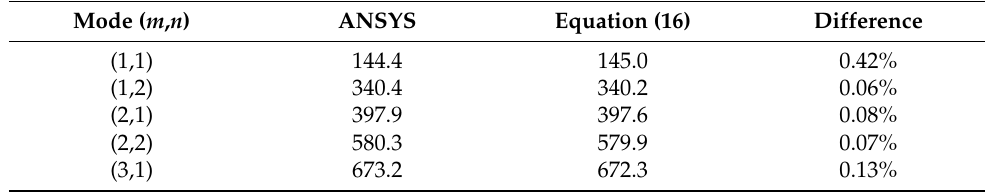
Figure 3. Mode (1,1) natural frequency of the composite laminate varying with the number of elements in the thickness. Table 1. Natural frequencies (Hz) of a simply supported composite laminate